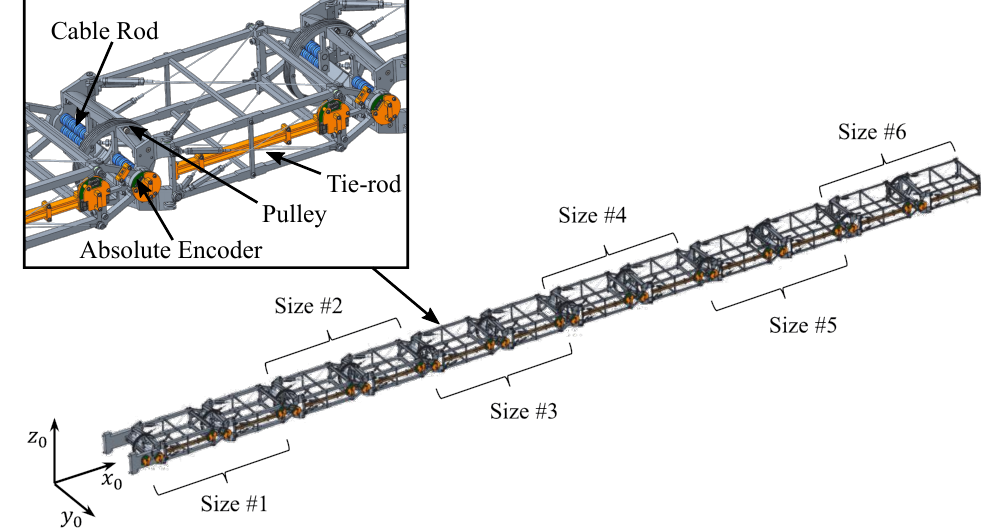
Figure 4. Details of a single module and its integration into the full 12 modules of the robotic